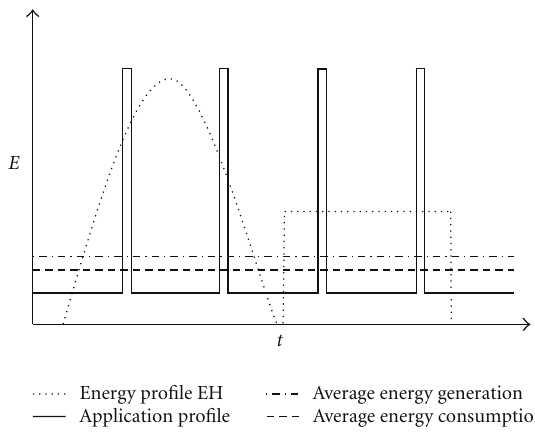
Figure 3: Energy profile of an energy harvester (EH) and its average energy generation versus an application profile and its average energy consumption. The average energy consumed must be lower than the average energy